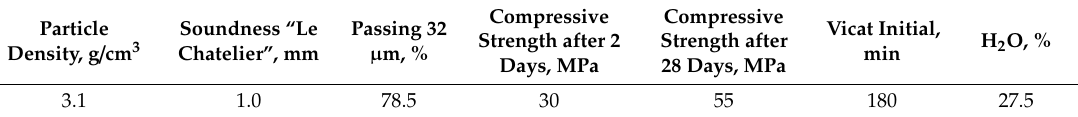
Table 2. Physical-mechanical properties of cement.